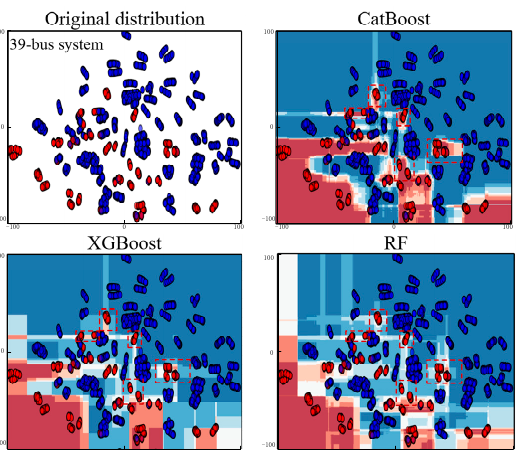
Figure 5. Visualization of prediction results. Red square in the figure represents the isolated unstable samples.